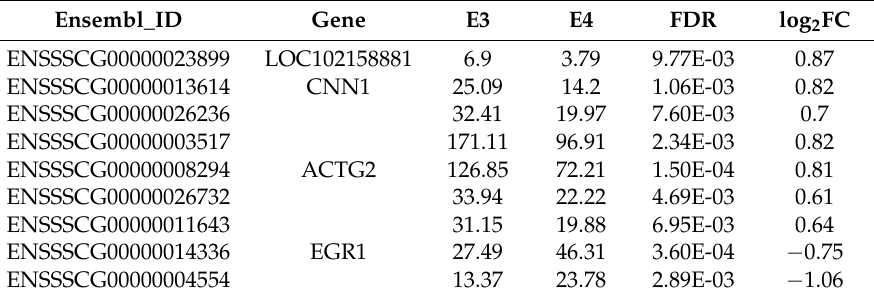
Table 4. Differential gene screening in